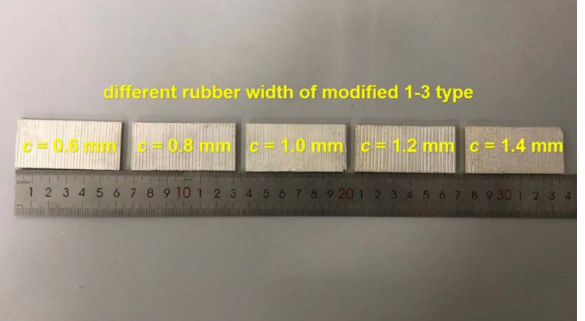
Figure 18. Sample diagram of modified 1-3 piezoelectric composites with different silicon rub- ber widths.